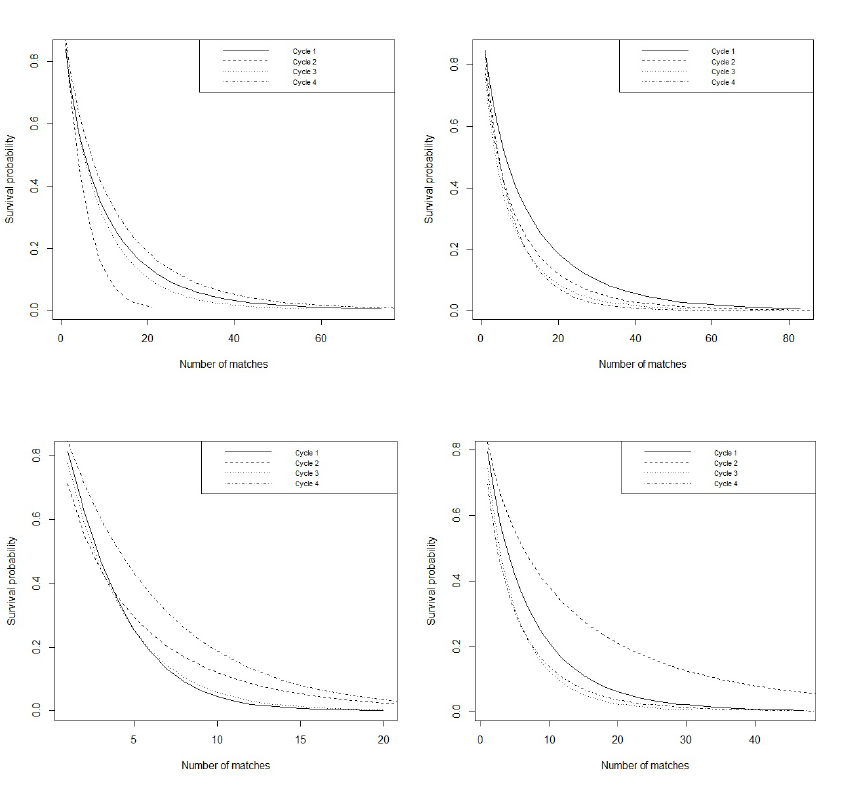
Figure 3 – Plots for the 1 st cycle comparing the fitted log-normal, Weibull and log-logistic curves with the Kaplan Meier curve (in the order batsmen inclusion and exclusion and bowler inclusion and exclusion, clockwise from upper